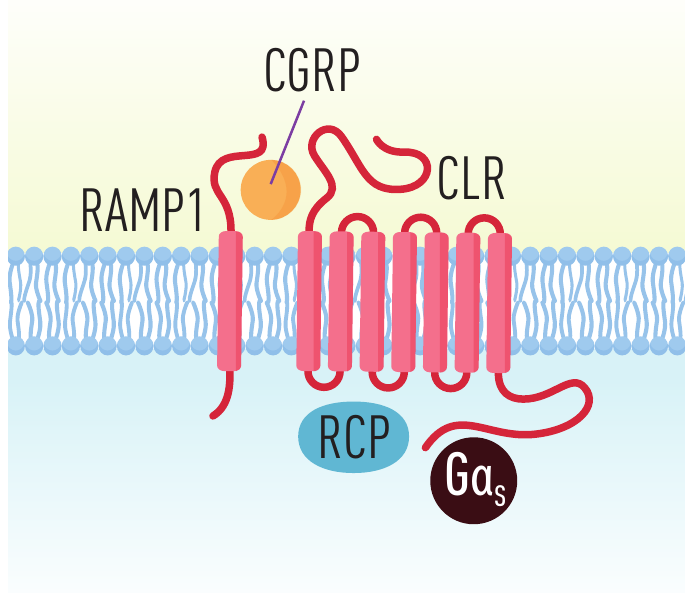
Figure 2. The CGRP receptor complex which consists of a G protein-coupled receptor called calcitonin receptor-like receptor (CALCRL), and a single transmembrane domain protein receptor, receptor activity-modifying protein (RAMP1) and two cytoplasmic proteins, receptor coupling protein (RCP) and the α -subunit of the GS protein (G α S